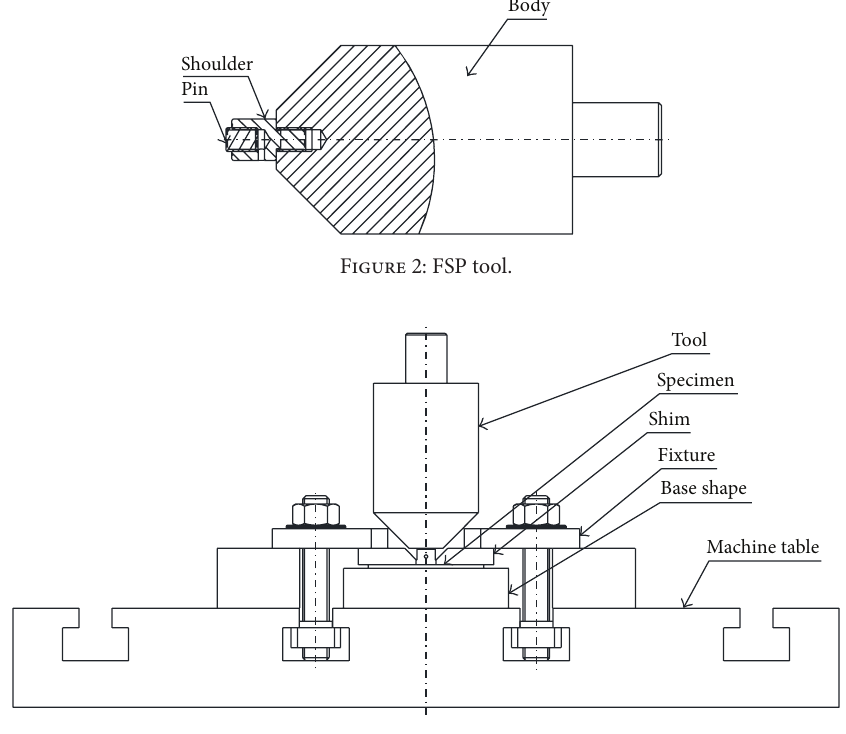
Figure 2: FSP tool.